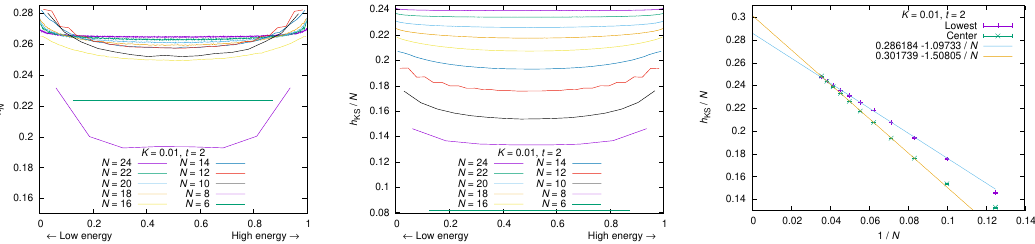
Figure 10 . The generalized Majorana SYK model with K = 0 : 01. [Left] At each N , the largest Lyapunov exponent (cid:21) N at t = 2 is shown as the function of the energy E i . The horizontal axis is ( i + 1 = 2) =L , so that the left and right corresponds to low and high energies. [Middle] h KS =N vs energy, at t = 2. [Right] h KS =N against 1 =N , for the ground state and the center of the energy